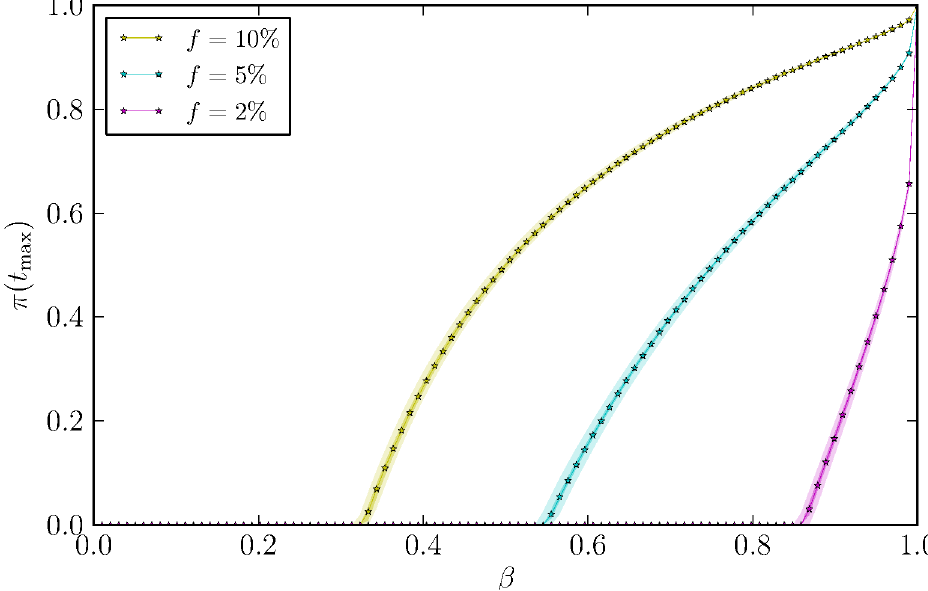
Figure 6. Median (line), interquartile (darker area) and 95 % confidence intervals (lighter area) of the final prevalence as a function of the transmission probability, for different values of f ( =2%, 5%, 10%), fraction of nymphs among ticks on a mouse, and by describing the ticks aggregation with the empirical distribution. Other parameters are N h ~ 10 4 , t max ~ 10 3 .